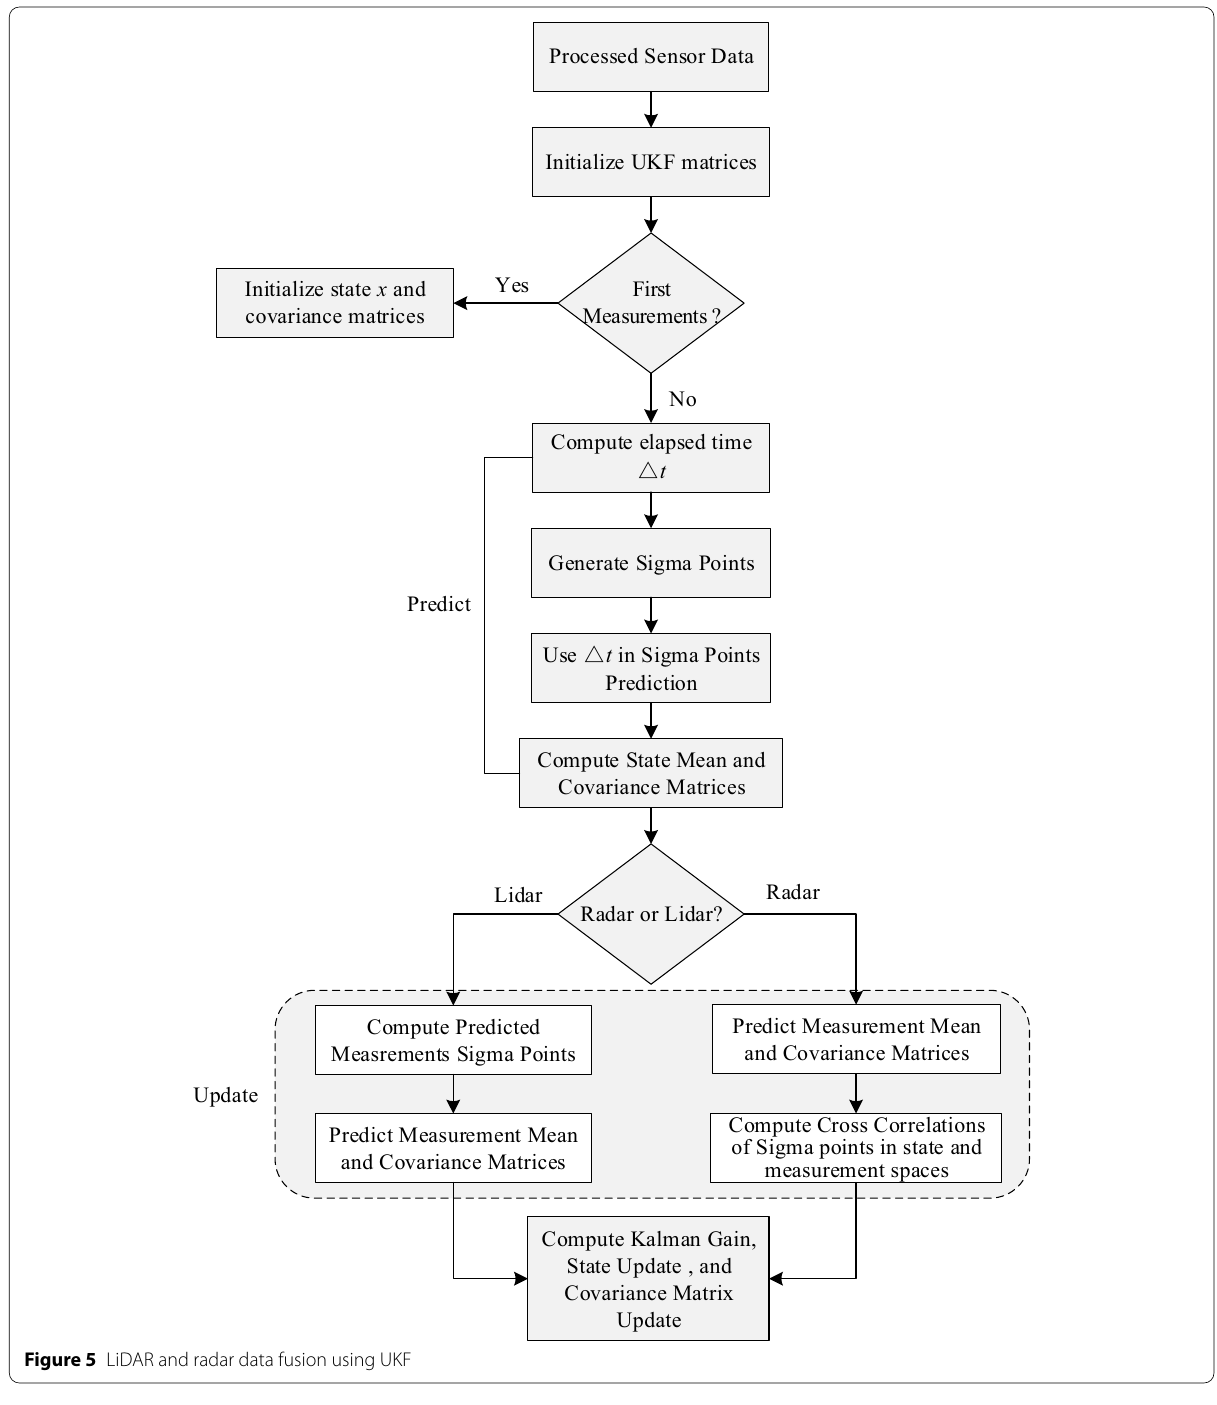
Figure 5 LiDAR and radar data fusion using